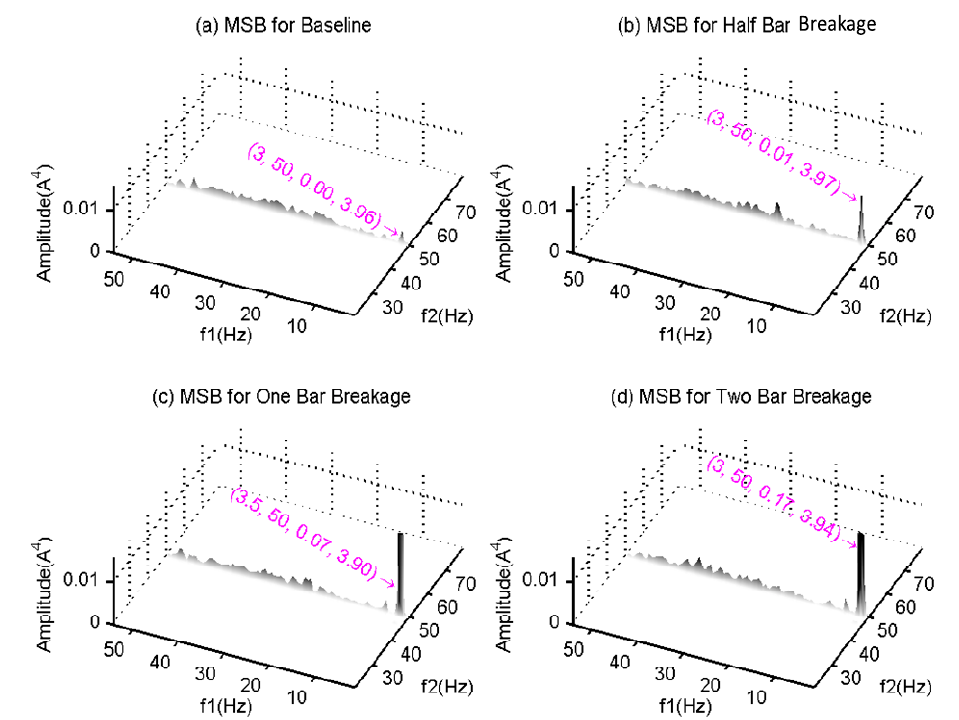
Figure 4. MSB magnitudes for baseline motor and BRB cases.